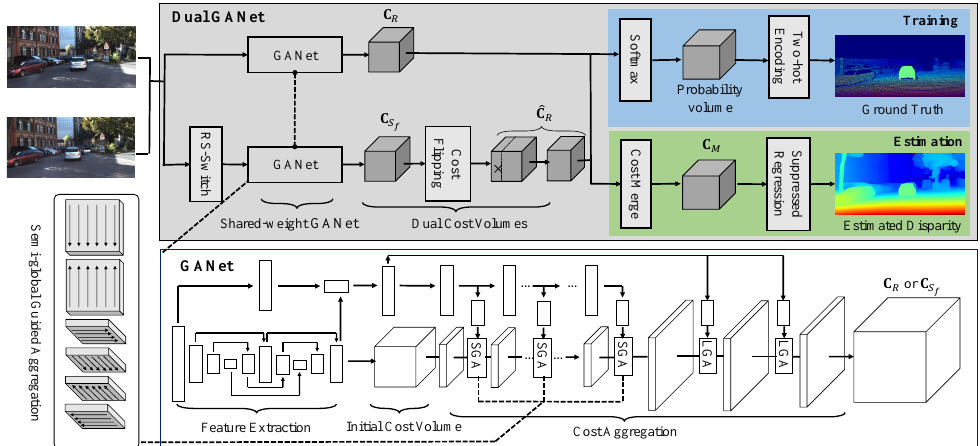
Figure 1. Overview of the Dual-GANet architecture. The Dual-GANet is a Siamese network con- taining the components of Siamese GANet, cost volume consistentization, flipped training (marked in blue), and suppressed regression (marked in green). The consistentization process consists of RS-Switch and cost flipping in the second